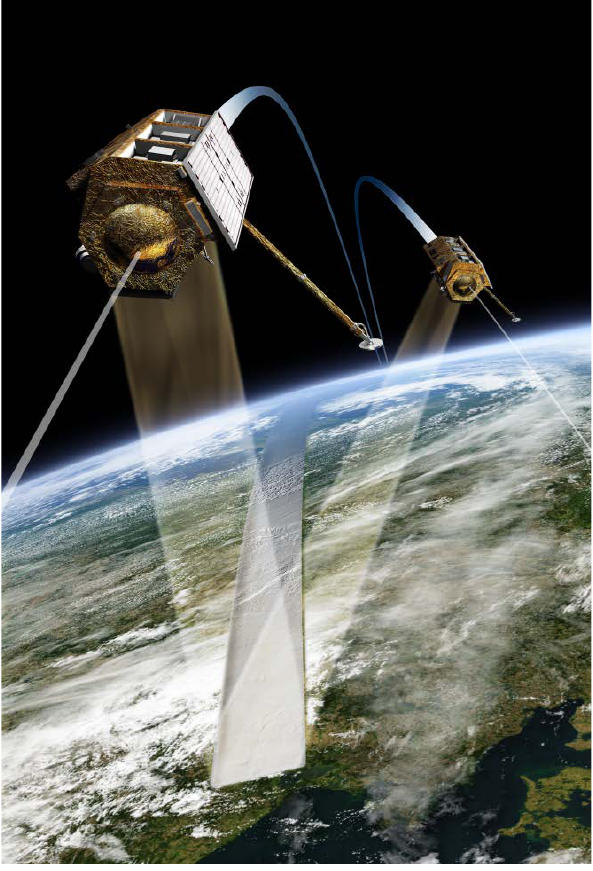
Figure 1. Artist’s view of TerraSAR-X and TanDEM-X flying